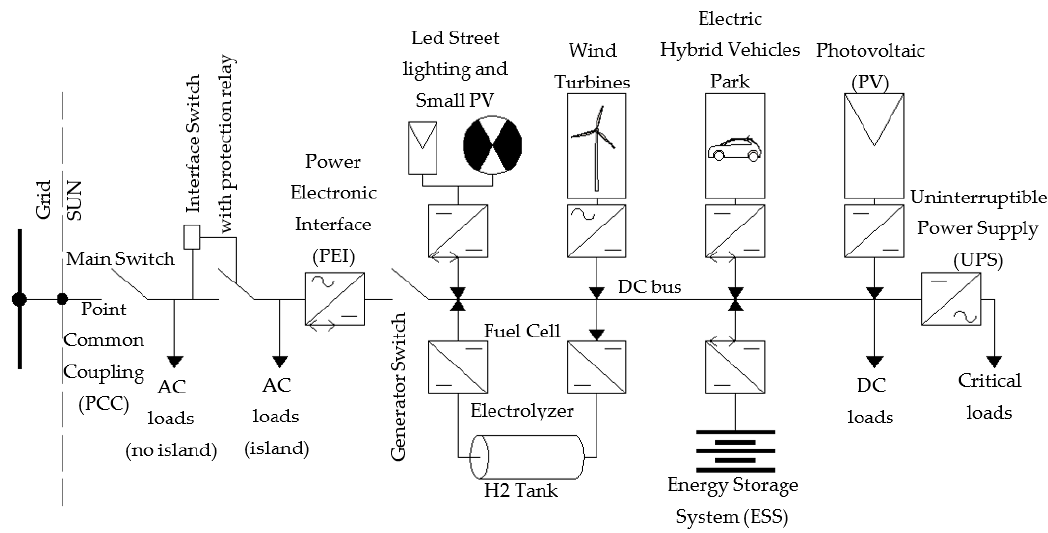
Figure 1. Smart User Network (SUN) configuration.